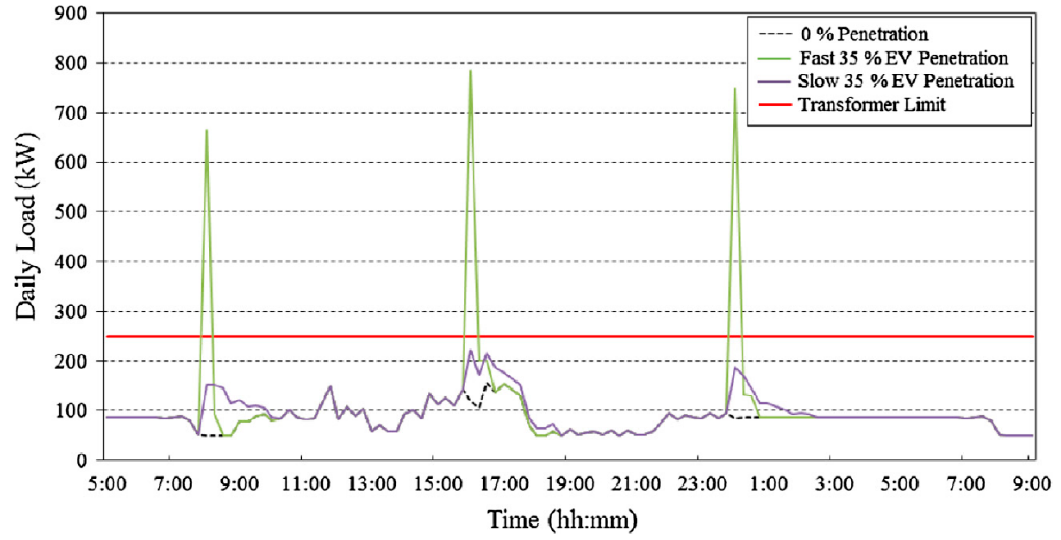
Figure 8. Transformer inputs in a fast and slow charge system by daily load versus time.